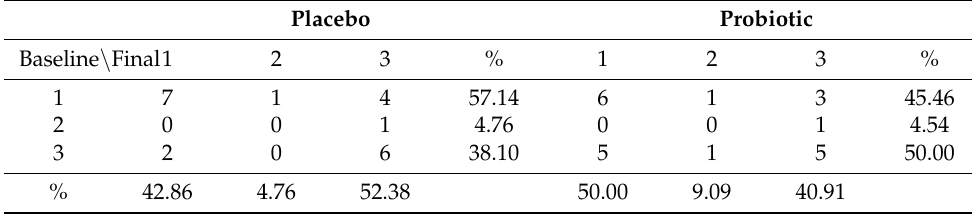
Table 1. Contingency enterotype analysis in both probiotic and placebo